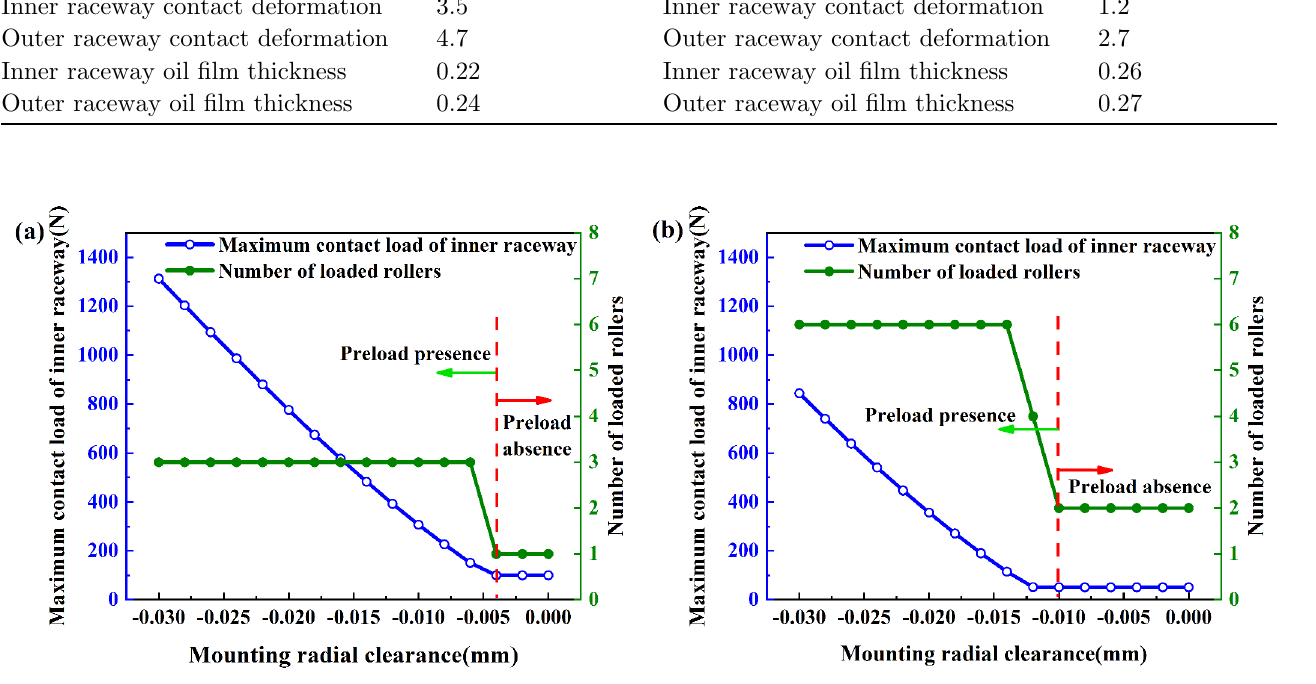
Fig. 7. The maximum contact load variation of the inner raceway and the number of loaded rollers variation under the different mounting radial clearances: (a) single-pressed state; (b) double-pressed